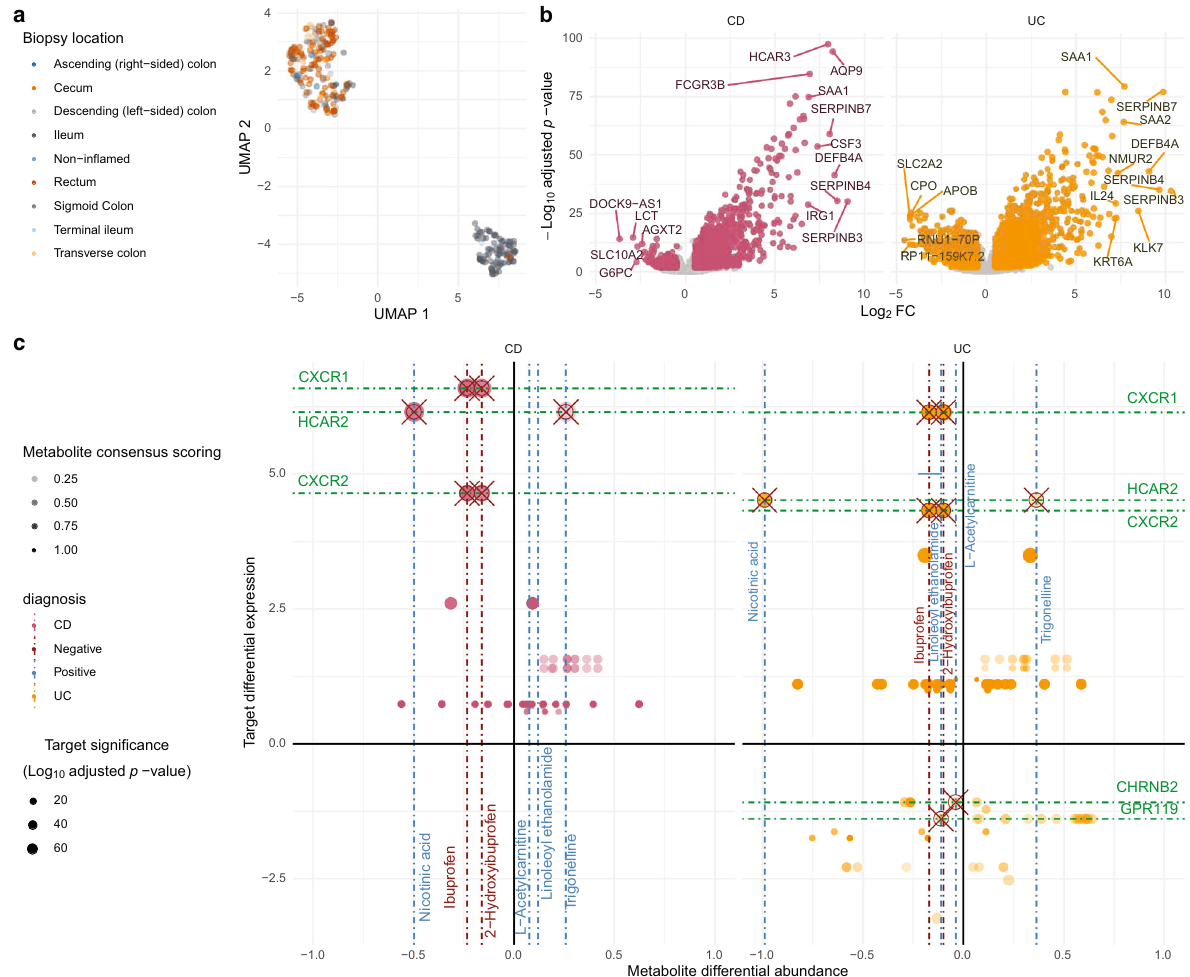
Fig. 3 Overview of the transcriptomics analysis results. a UMAP analysis of the transcriptomic samples by biopsy location. b Volcano plots representing target differential expressions in Crohn ’ s disease (CD) and Ulcerative Colitis (UC) states by FDR-adjusted p value. c Cross-plot showing possible interactions of interest between targets with expression on the vertical axis and perspective modulator metabolite differential abundances on the horizontal axis, per each disease type (refer to Table 1 for samples